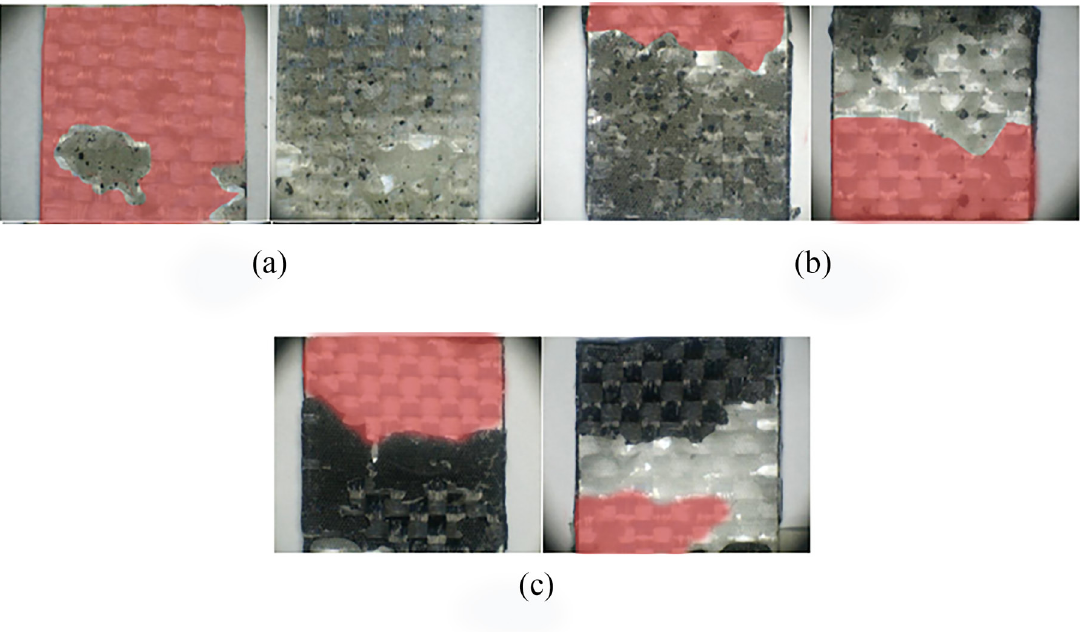
Figure 8. Failure modes for adhesive + 0.5 wt% CNT. (a) Group A05-005; (b) Group A05-015; (c) Group A05-040. Areas in red indicating the LFT failures.